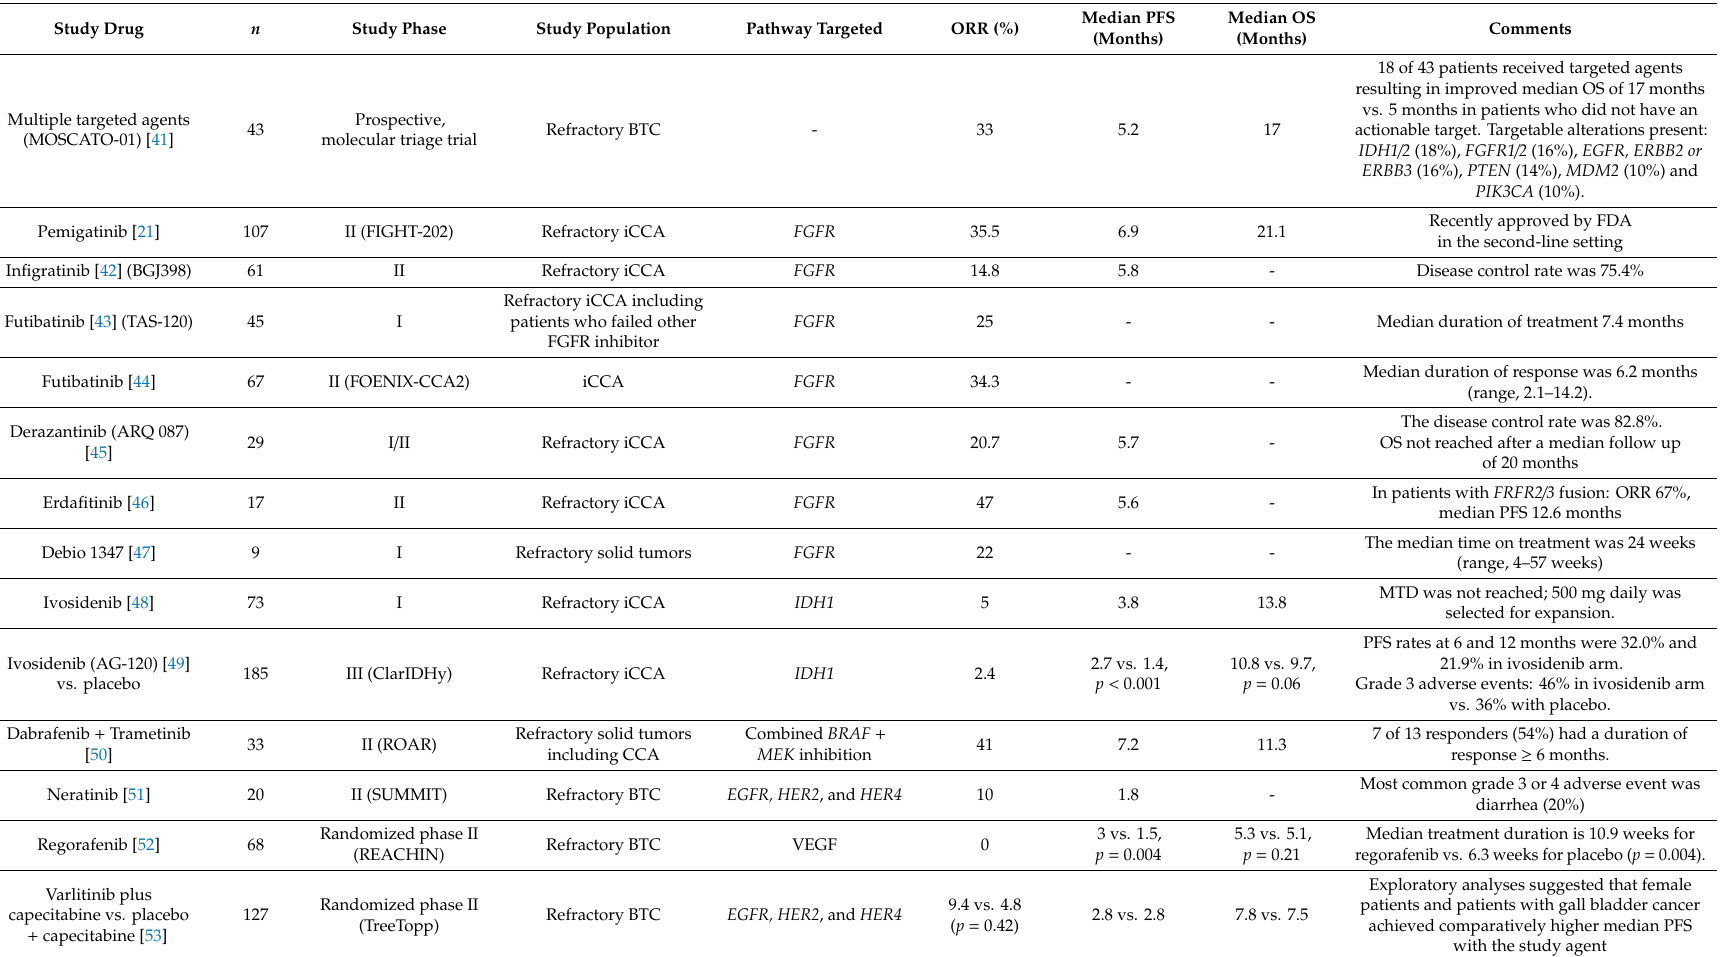
Table 3. Published study results of targeted therapies in patients with advanced biliary tract carcinoma